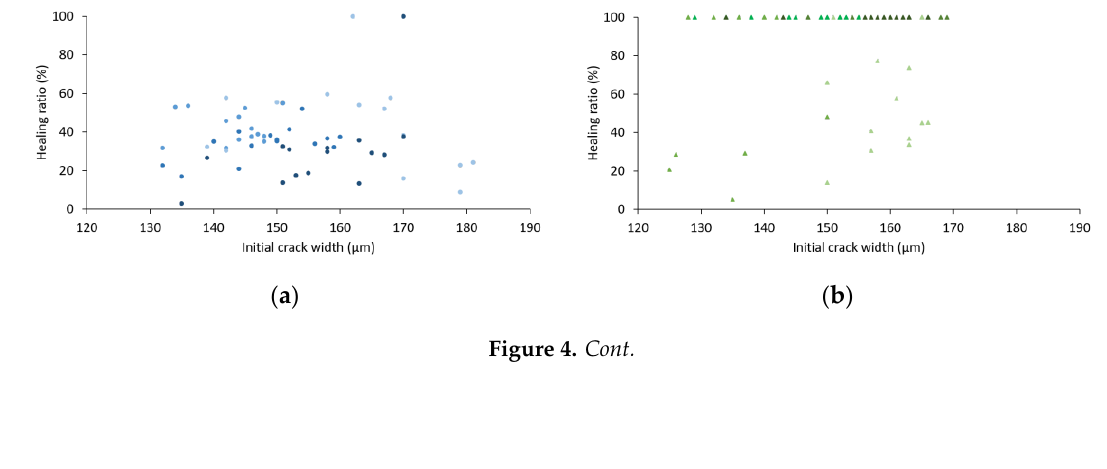
Figure 3. Evolution of crack width over time of ( a ) reference, ( b ) 0.2% SAP, ( c ) 2% HS-40 and ( d ) 0.2% SAP + 2% HS-40. The different curves represent the various specimens of each series that were tested.